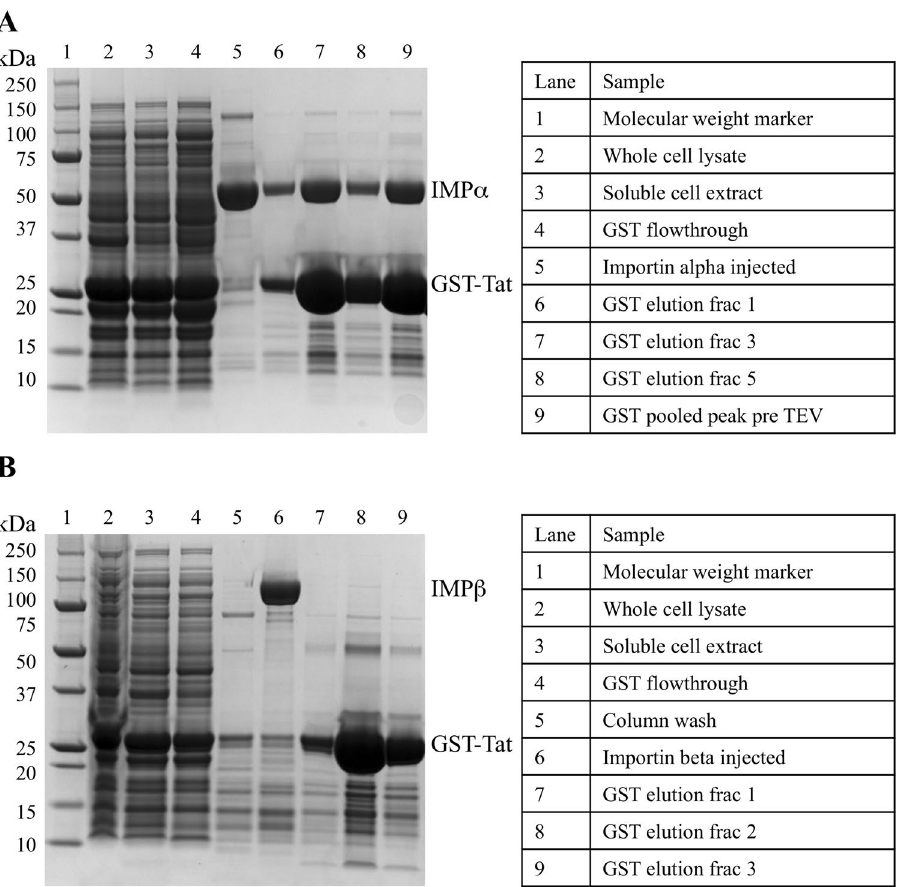
Figure 1. Binding of Tat:NLS/CPP to importin- α and importin- β . ( A ) SDS-PAGE visualization of complex formation between Tat:NLS/CPP and importin- α . ( B ) SDS-PAGE revealing a lack of complex formation between Tat:NLS/CPP and importin- β . Both gels were cropped at the right to remove samples from additional purification steps and other experiments. The full gels are presented in the Supplementary Figure